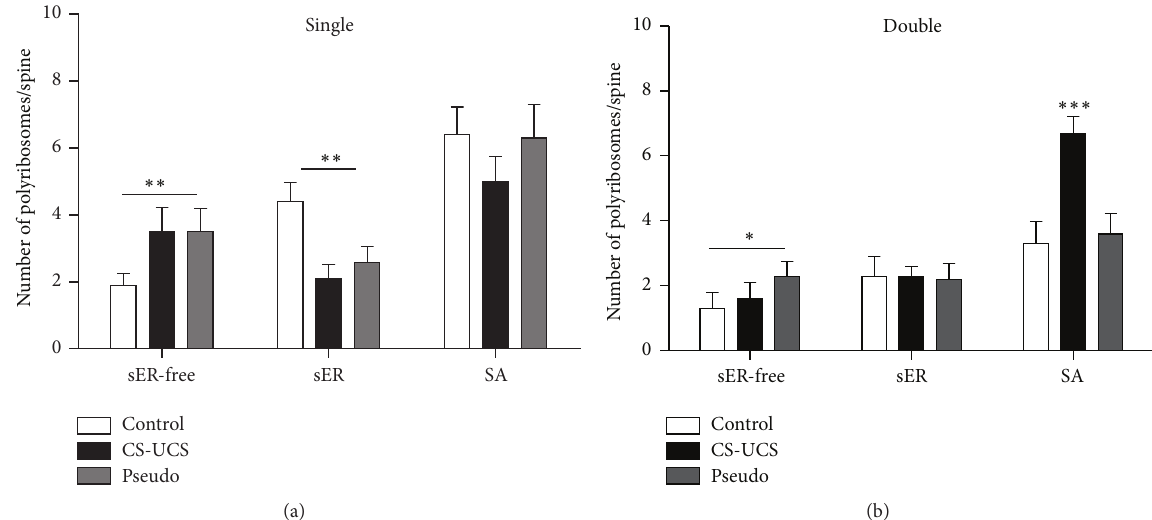
Figure 6: Number of polyribosomes in the single- (a) and double-synapse spines (b): sER-free, containing sER, and containing SA. The graphs show means ± SEM (chi square test and one-way ANOVA with post hoc Tukey’s test: ∗∗∗ 𝑃 < 0.001 , ∗∗ 𝑃 < 0.01 , and ∗ 𝑃 < 0.05 ).